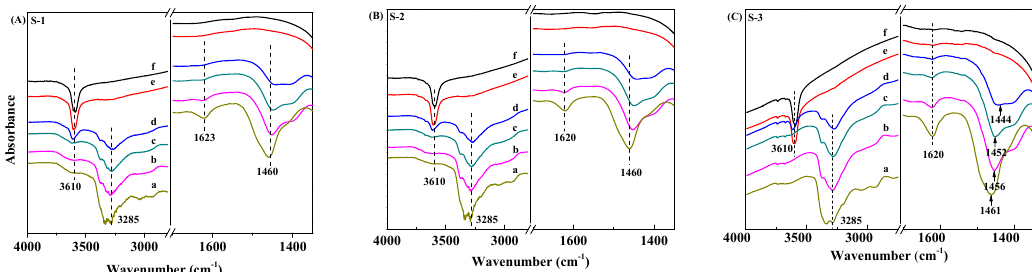
Figure 5. The FT-IR images for ( A ) S-1, ( B ) S-2, and ( C ) S-3 at given temperatures after NH 3 adsorption, a: 323 K; b: 373 K; c: 423 K; d: 473 K; e: 573 K; and before NH 3 adsorption, f: 323